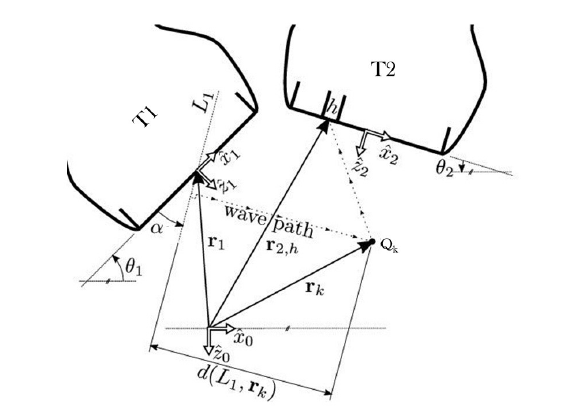
Figure 1. Coherent multi-transducer ultrasound (CoMTUS) beamforming scheme. The global and local coordinates of the arrays are shown. In this example, array T1 transmits a plane wave (PW) at angle α , and array T2 receives the resulting echoes backscattered from the scatter Q k